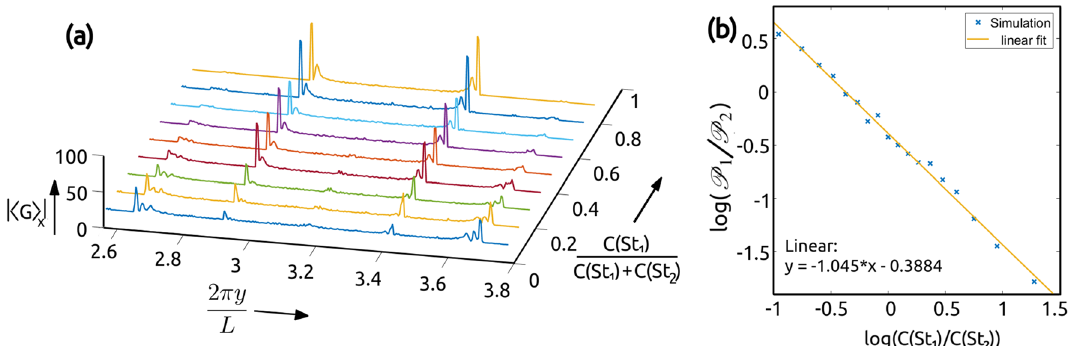
Figure 6. The plot (a) shows the variation in the absolute value of (cid:31) G (cid:30) x for a bi-disperse system, with St 1 = 1 and St 2 = 2 particles, for various initial concentration fraction C ( St 1 )/( C ( St 1 ) + C ( St 2 )) . Notice that the peaks corresponding to each wavefront is not unique and have a finite spread in y. In (b) the relation between the prominence corresponding to St 1 and St 2 are given by P 1 , P 2 respectively, as a function of the initial particle concentrations C is shown in a log–log plot. The linear fit shows that the ratios of the peaks of ˆ|� G �| and the ratios of the concentration are related by a power-law, with a power close to −1. The plots were generated using Matlab 2020a, https:// www. mathw orks. com/ produ cts/ matlab.